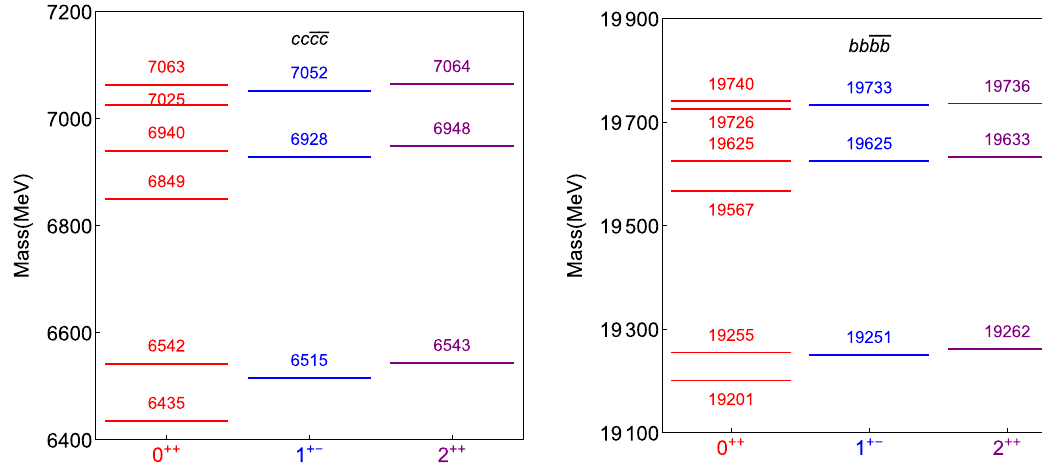
Fig. 2 The predicted masses of cc ¯ c ¯ c and bb ¯ b ¯ b systems Table 5 The color proportions and root mean square radii of the radial excited states for cc ¯ c ¯ c and bb ¯ b ¯ b systems. The units of masses and root mean square radii are in MeV and fm, respectively